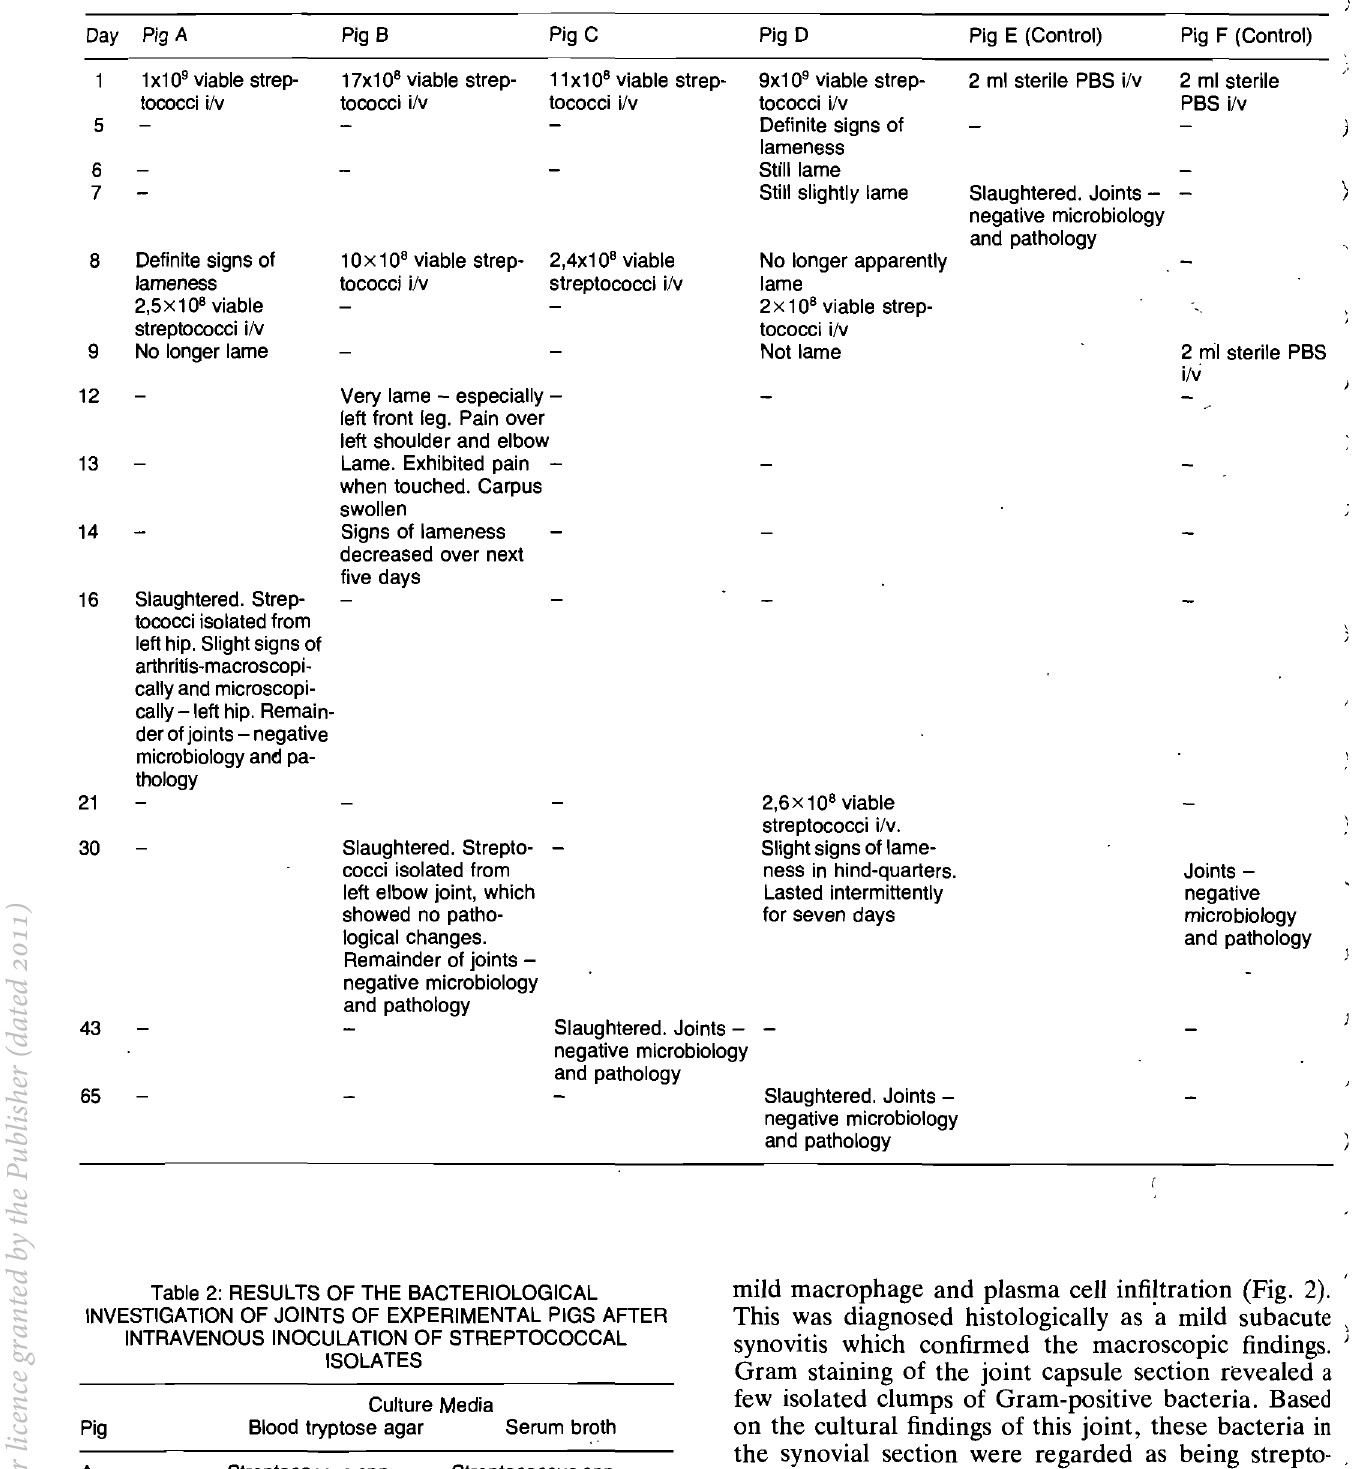
Table 1: SUMMARY: RESULTS OF INTRAVENOUS INOCULATION OF STREPTOCOCCAL ISOLATES INTO EXPERIMENTAL PIGS Day Pig A